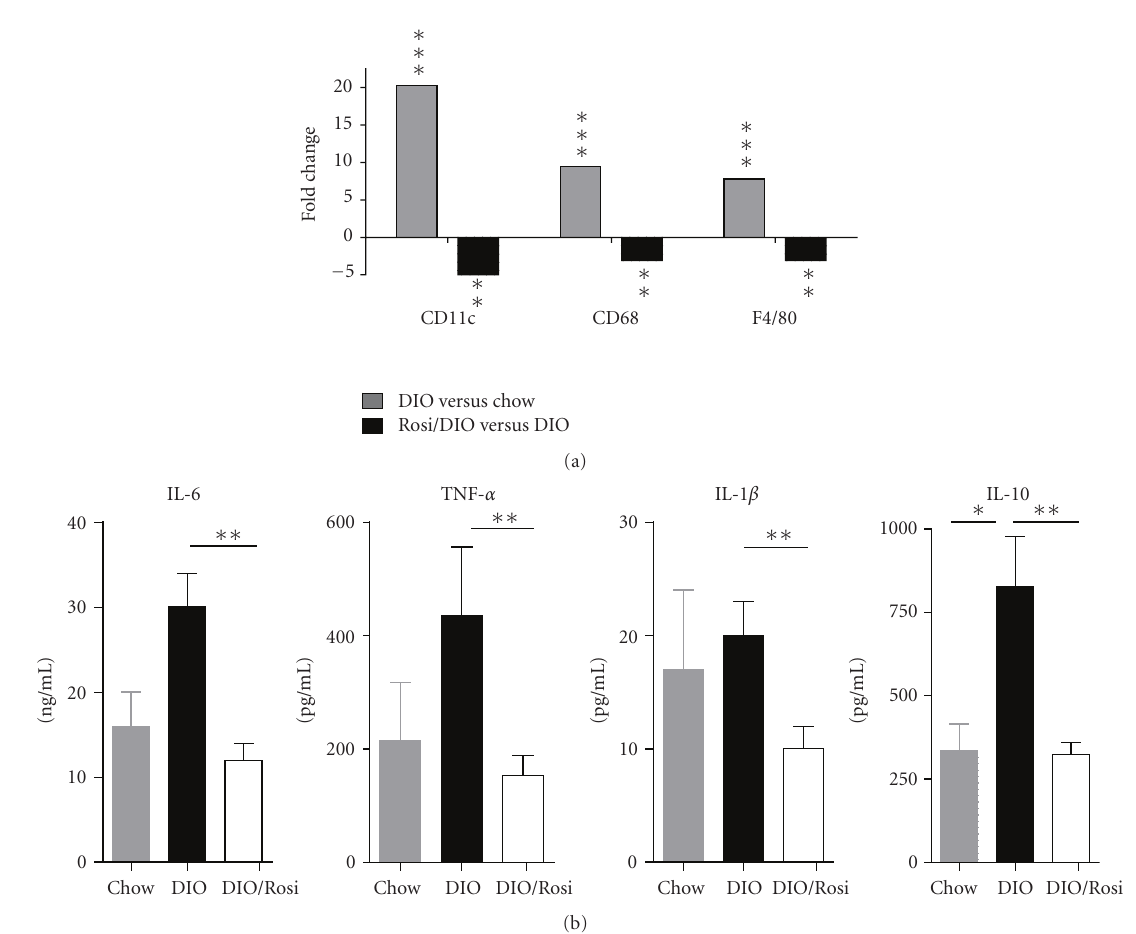
Figure 6: Rosiglitazone reduced macrophage and pro-inflammatory markers by gene expression as well as ex vivo spontaneous mediator production. (a) Gene expression of macrophage markers was analyzed from the epididymal fat pads. Data is represented as DIO gene expression fold induction versus the chow cohort or DIO animals treated with Rosiglitazone versus the DIO cohort ( n = 8 mice/group). Statistical significance was determined by a two-tailed Welch t -test; ∗ P < . 05, ∗∗ P < . 01, and ∗∗∗ P < . 001. (b) Stromal vascular cells were isolated from the EF and incubated ex vivo. Spontaneous mediator production was assessed ( n = 8 mice/group). Values represent the mean and SEM. Mann-Whitney U test was used to compare standard chow to DIO or DIO to DIO/rosiglitazone; ∗ P < . 05 and ∗ P < . 01.